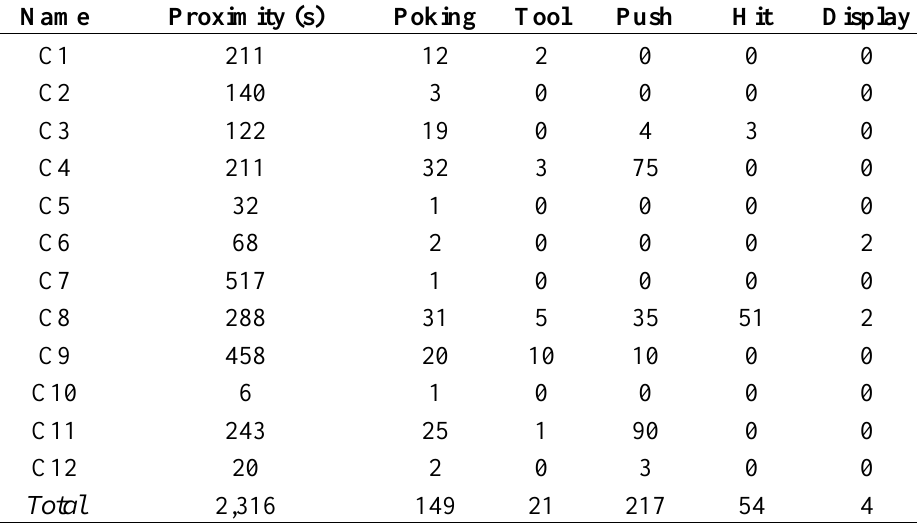
Table 3. Duration of proximity to the wired device and frequency of interaction (by interaction type) performed by 12 individual